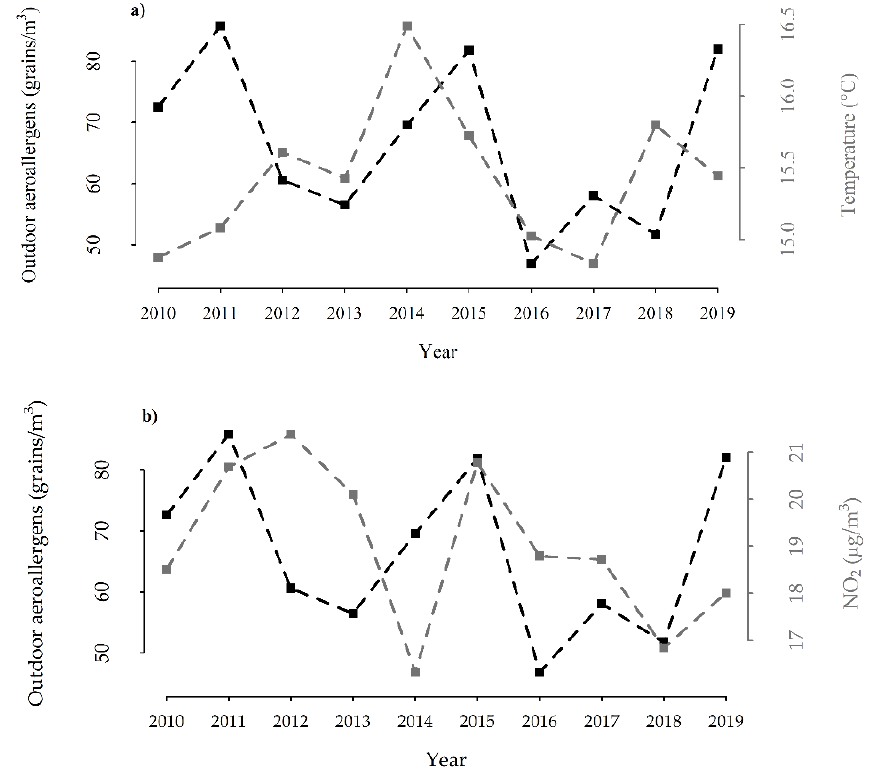
Figure 1. ( a ) Annual means of total outdoor allergen counts and apparent temperatures recorded in the study area; ( b ) annual means of total outdoor allergen counts and NO 2 .